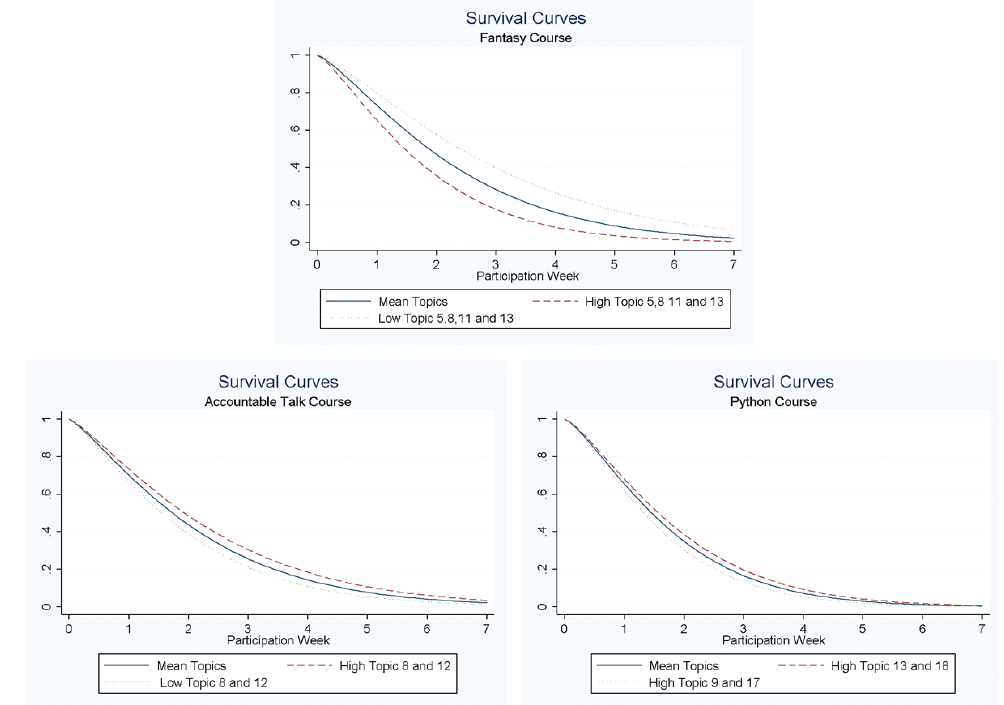
Figure 2. Survival curves for significant topics in three